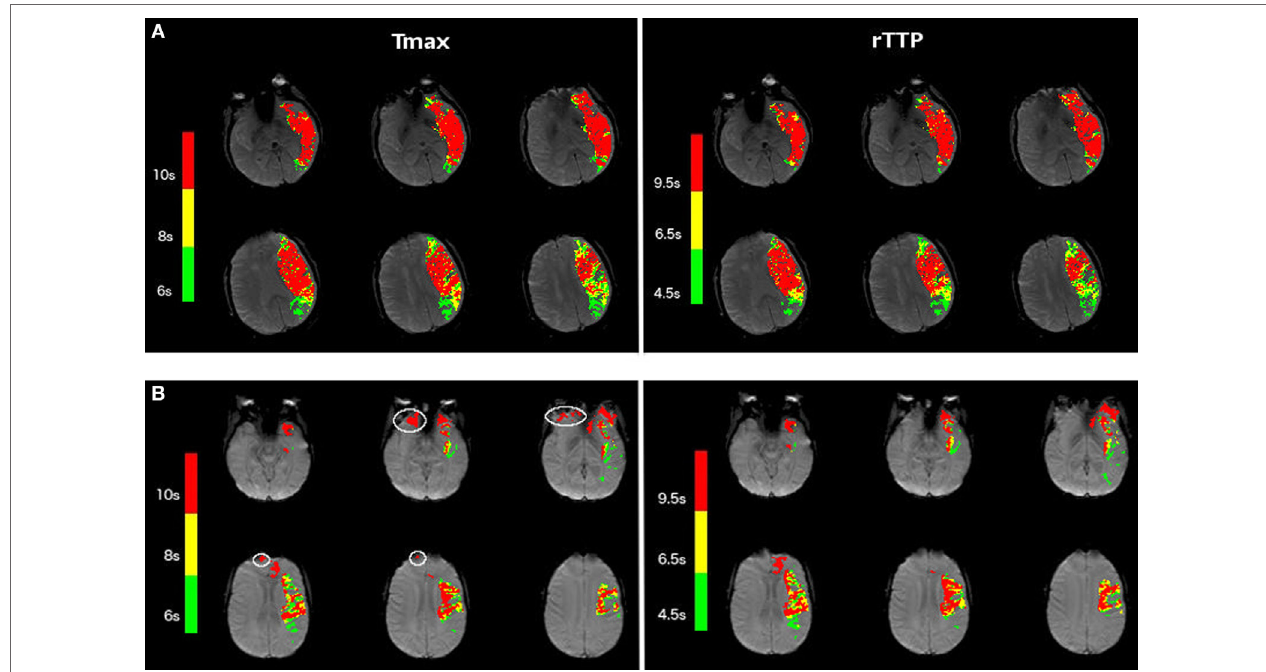
FigUre 1 | Examples of Tmax and relative TTP (rTTP) maps in acute stroke patients. (a) Shows the Tmax (left) and rTTP (right) perfusion maps of a patient with a left-hemispheric stroke, which illustrates the correspondence in volume and shape of the stroke lesion between Tmax and rTTP. (B) Illustrates another example of Tmax (left) and rTTP (right) perfusion maps in a patient with a left-sided stroke. White contours on the Tmax map depict small artifacts. This example illustrates that, in certain cases, the rTTP map is less susceptible to image